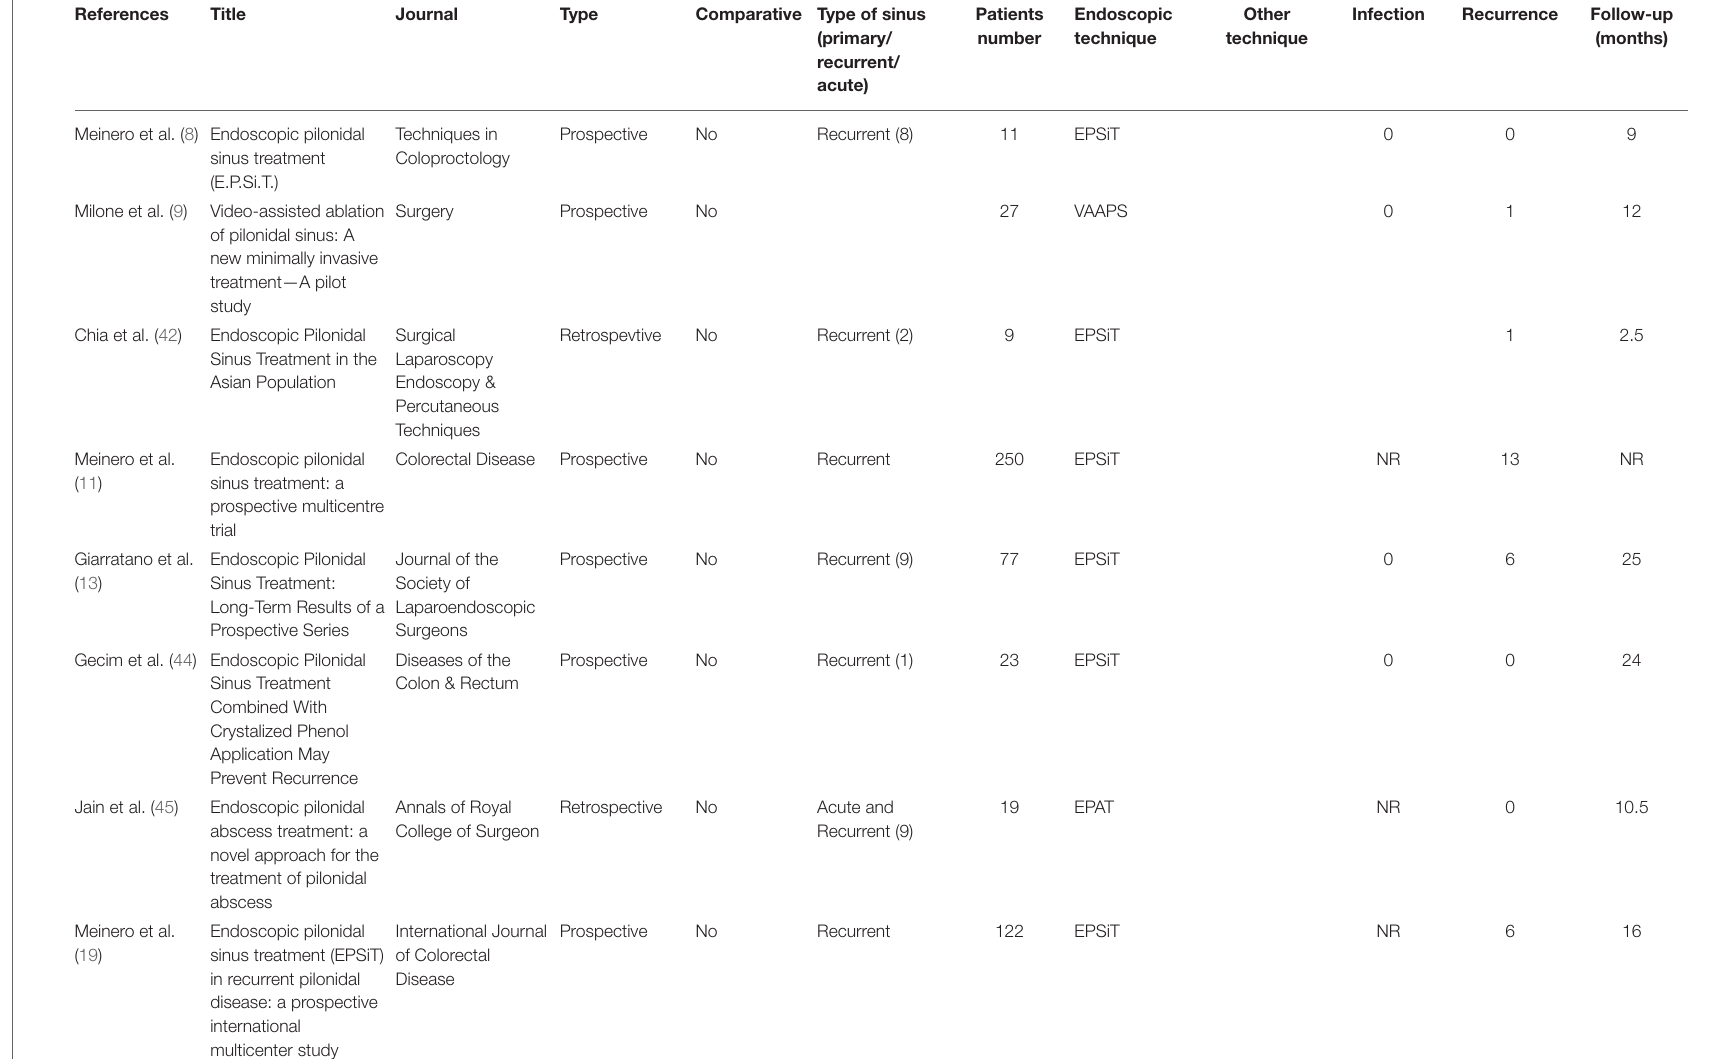
TABLE 1 | Cohort studies on the endoscopic approach in the adult